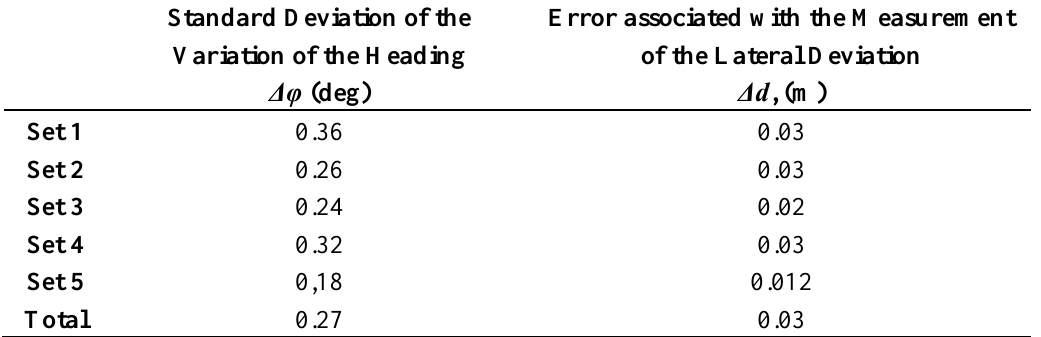
Table 2. Standard deviations of the variations of the heading and the error associated with the calculation of the lateral displacement of the line-of-sight related to the crop lines detected by the perception